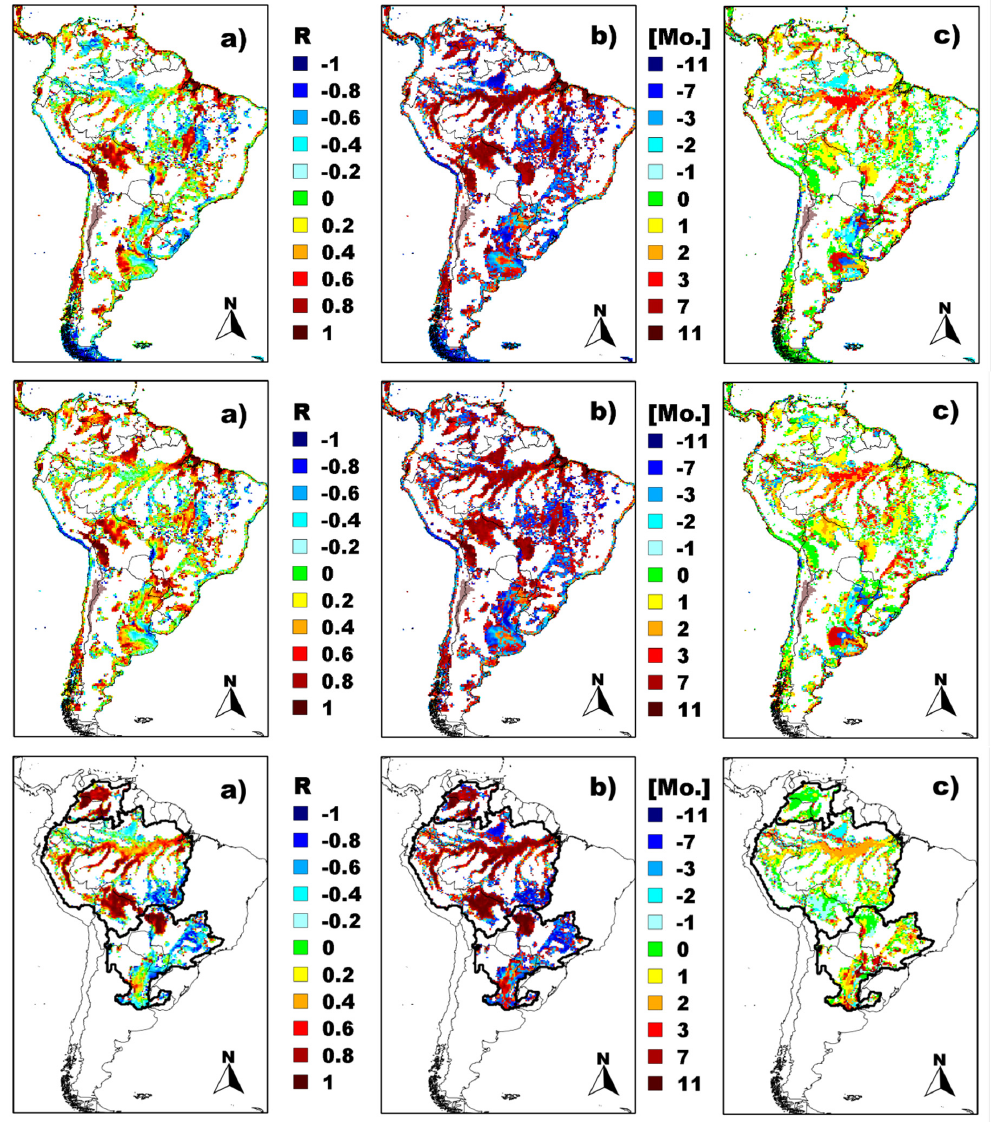
Figure 12. ( a ) Pixel-wise linear correlation (R); ( b ) maximum cross-correlation (R); and ( c ) associated time lag in months between total monthly MERRA precipitation (top), total monthly TRMM precipitation (middle), and monthly mean river discharge from WBM simulations (bottom) and corresponding monthly mean fractional water (FW) for South America (55°S–15°N, 35°W–85°W) over the 13 year combined v1-QSCAT (2000–2008) and v2-ASCAT (2009–2012) record. Black lines (bottom) indicate basin limits for the Orinoco, Amazon and Parana River basins. Areas in white are outside of the domain/basins or are screened (average annual FW < 0.1%) from the analysis. Actual figure color is a linear interpolation of the colors in the legend. Map projection same as Figure 2. Distance covered by one degree of latitude is approximately 111-km.